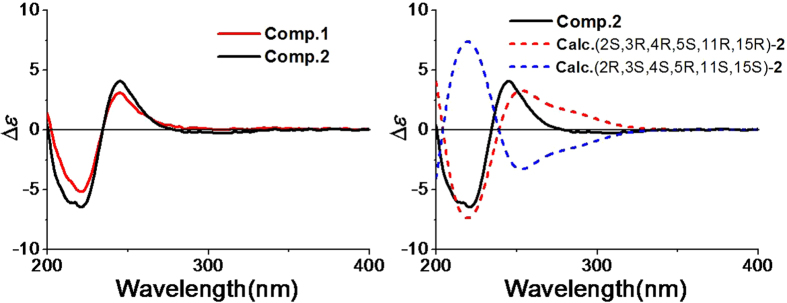
Experimental ECD spectra of 1–2 and calculated ECD spectra of (2S, 3R, 4R, 5S, 11R, 15R)-2 and (2R, 3S, 4S, 5R, 11S, 15S)-2.